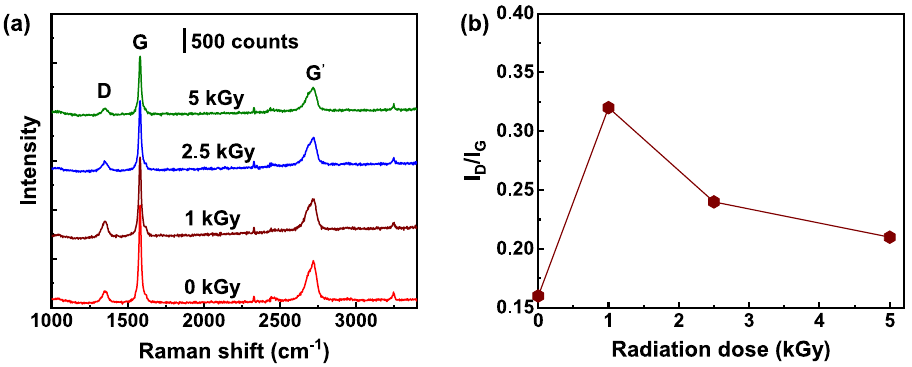
Figure 2. Raman spectroscopy analysis. ( a ) Raman spectra of GnF with varying gamma-ray radiation doses of 0.0, 1.0, 2.5, and 5.0 kGy. ( b ) I D /I G ratio as a function of radiation